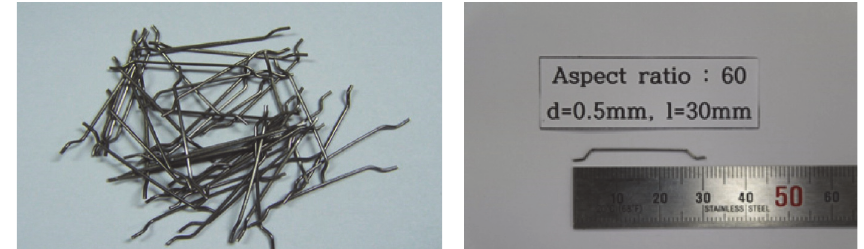
Figure 2: Type of steel fiber (hooked end).